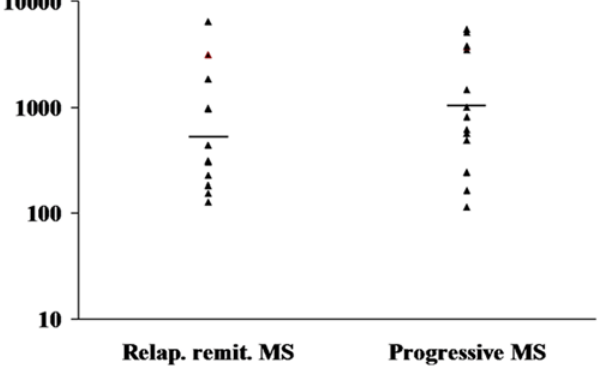
Figure 1. Dotplot of copy numbers of C.pneumoniae DNA in relapsing remitting MS (left) and progressive MS (right) patients. Horizontal bars indicated the geometric mean copy numbers, which were 567.7 and 1,009.6 copies/ml (geometric mean load) for relapsing remitting and progressive MS, respectively (p . 0.05). doi:10.1371/journal.pone.0005200.g001 PLoS ONE |